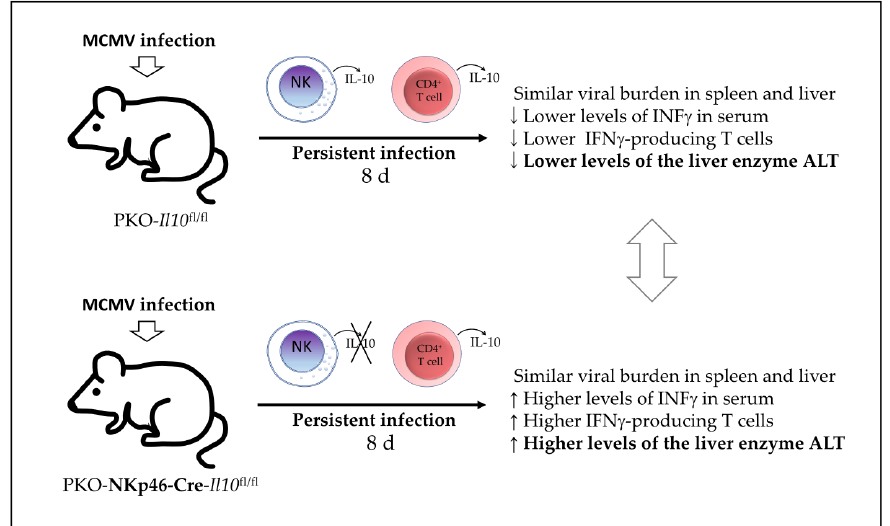
Figure 5. Proposed model of the role of IL-10-producing NK cells in murine cytomegalovirus (MCMV) infection. IL-10- producing NK cells prevent liver damage and potentially regulate production of INF γ in a model of perforin-deficient mice (PKO). PKO mice suffer from persistent MCMV infection, with NK cells and CD4 + T cells as the main source of IL-10 at 8 days post-infection. PKO-IL-10-deficient NK cell mice (PKO-NKp46-Cre-Il10 fl/fl ) show increased liver damage (higher levels of the liver enzyme ALT), increased serum levels of INF γ, and INF γ + T cells, but a viral burden similar to the infected PKO control mice (PKO-Il10 fl/fl ). MCMV — murine cytomegalovirus; PKO mice — perforin-deficient mice; ALT — alanine